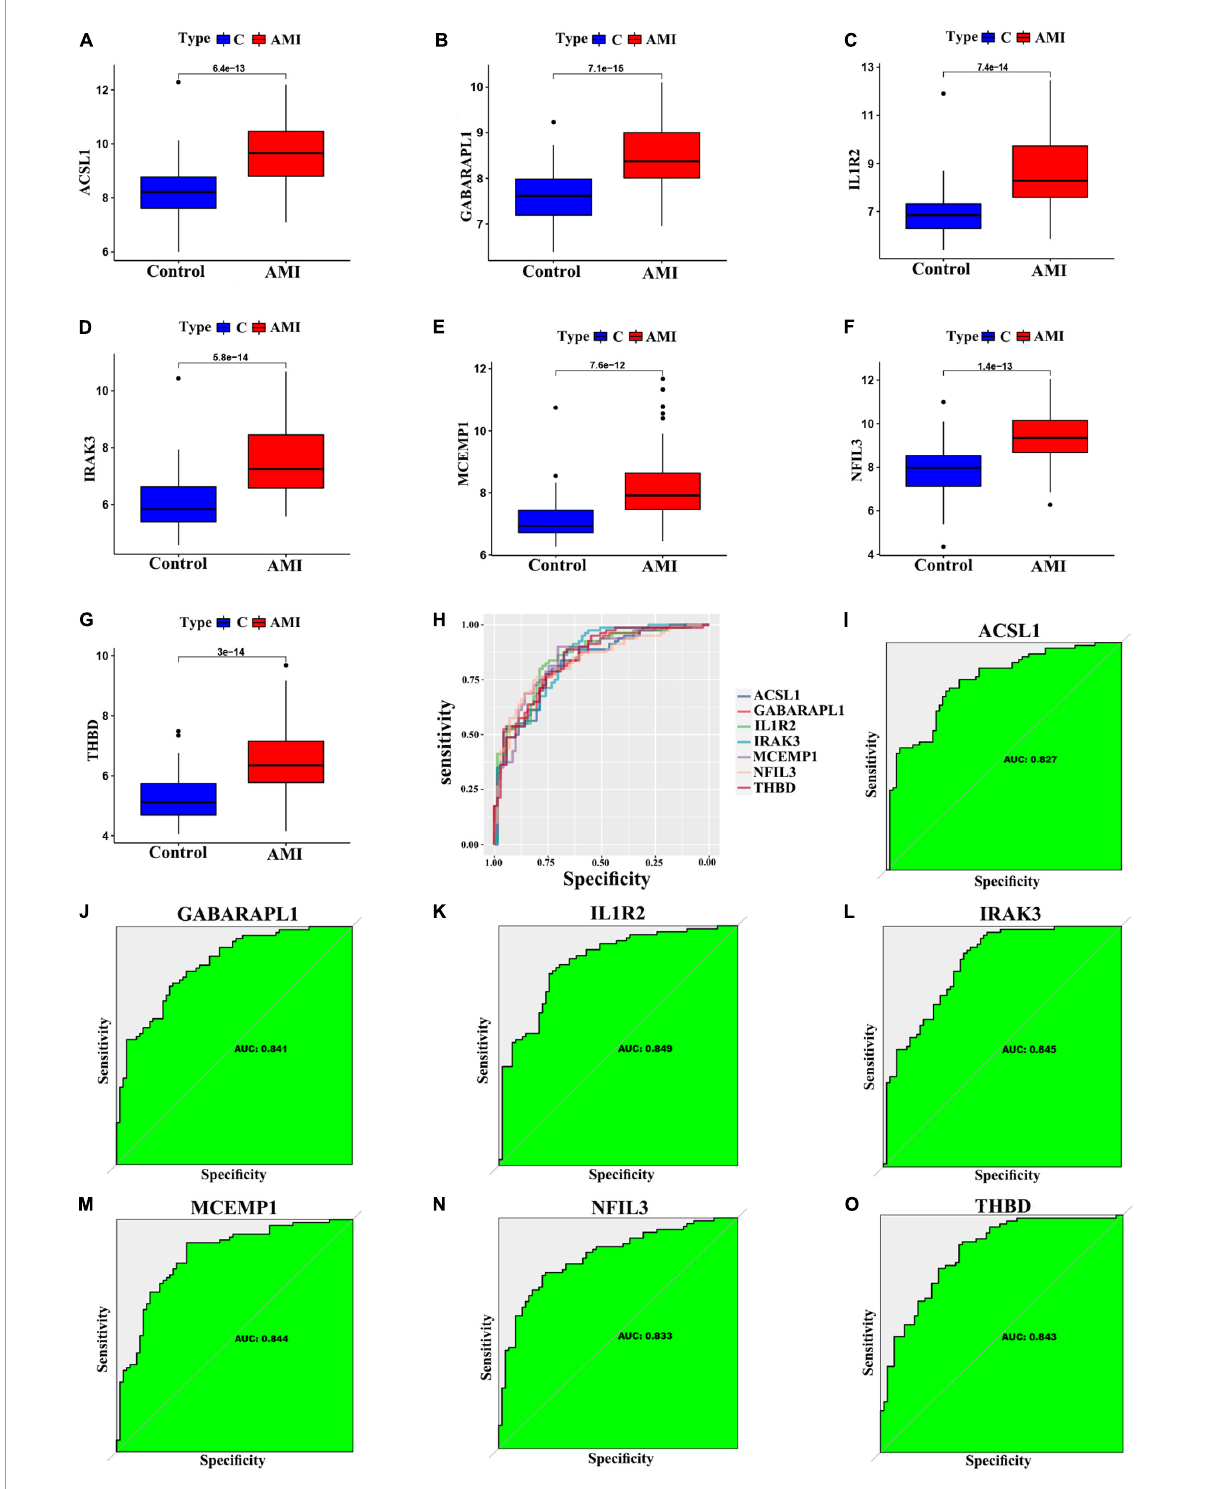
FIGURE6 Verification of expression and diagnostic efficacy in predicting AMI progression of optimal feature genes. (A–G) Box plots showing the expression of ACSL1 (A) , GABARAPL1 (B) , IL1R2 (C) , IRAK3 (D) , MCEMP1 (E) , NFIL3 (F) , and THBD (G) in control and AMI samples. Statistic tests: Wilcoxon rank-sum test. (H–O) Roc curves (H) estimating the diagnostic performance of ACSL1 (I) , GABARAPL1 (J) , IL1R2 (K) , IRAK3 (L) , MCEMP1 (M) , NFIL3 (N) , and THBD (O)